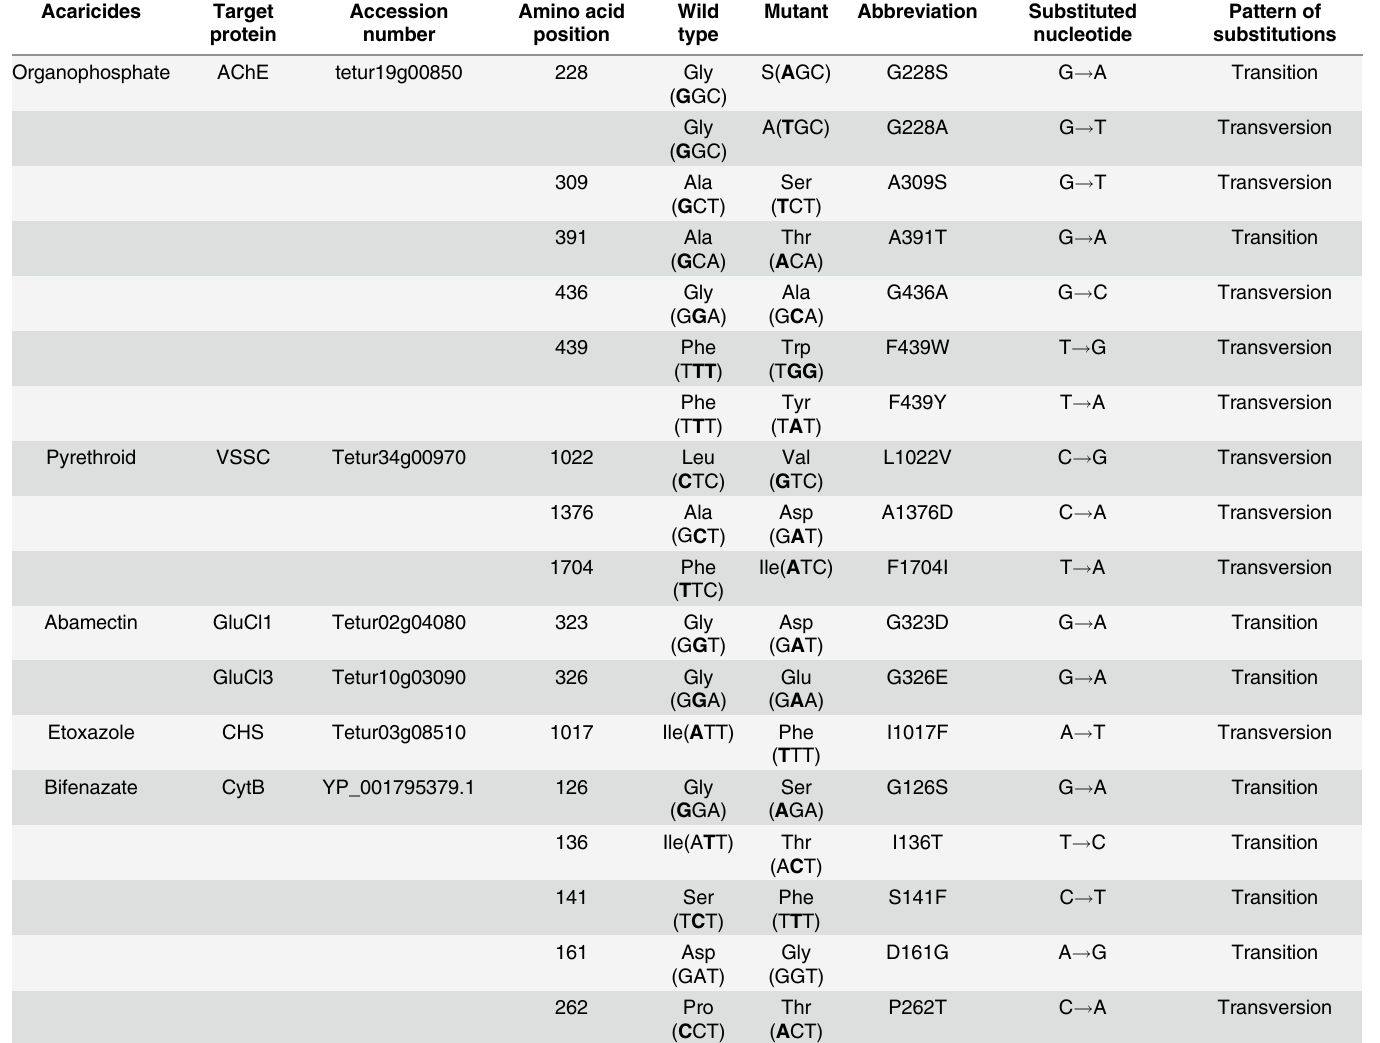
Table 1. Transition and transversion of point mutation associated acaricides resistance in Tetranychus urticae